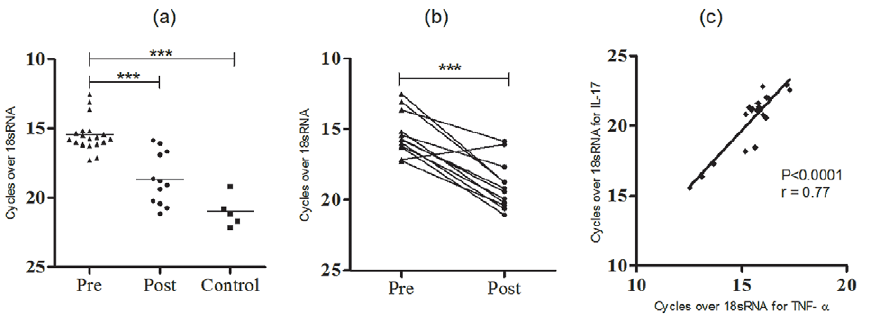
Figure 6. mRNA expression of TNF- a and its correlation with IL-17. Relative mRNA levels of TNF- a in lesion tissues of PKDL patients determined by real time PCR (a) at pretreatment (n=19) or post treatment (n=12), or control tissues (n=5) or (b) in paired samples (n=12) and (c) Correlation between IL-17 and TNF- a expression in tissue lesions of PKDL. (r) represents Spearman’s rank correlation coefficient. **P , 0.01, and ***P ,